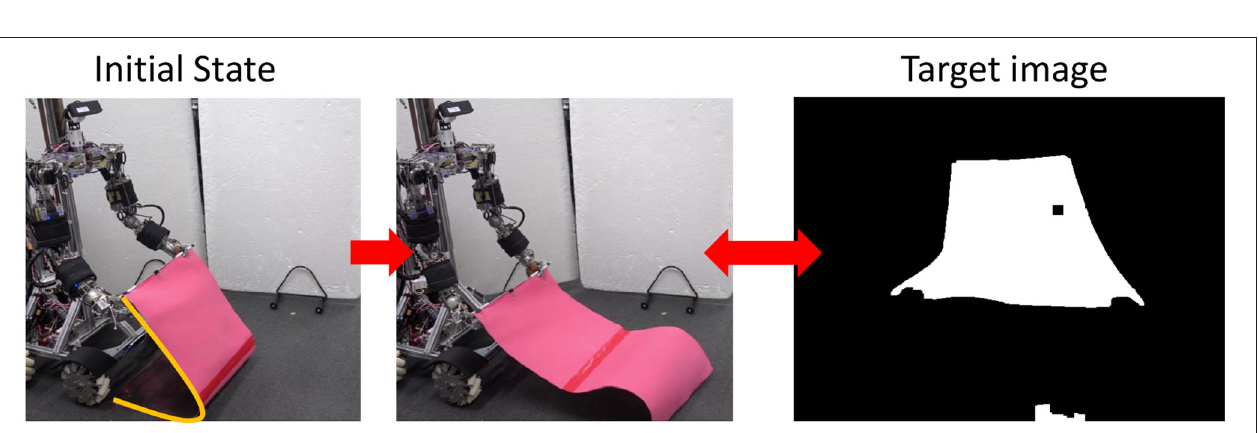
FIGURE 10 | Experimental setup for the actual robot experiment: the initial state of cloth and target image of spread-out cloth.